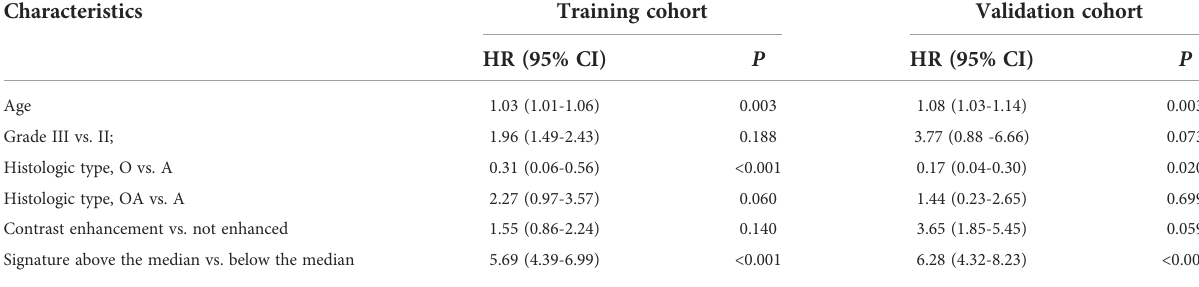
TABLE 3 Multivariate Cox regression analyses for overall survival in the training and validation cohorts of patients with LGG. Characteristics